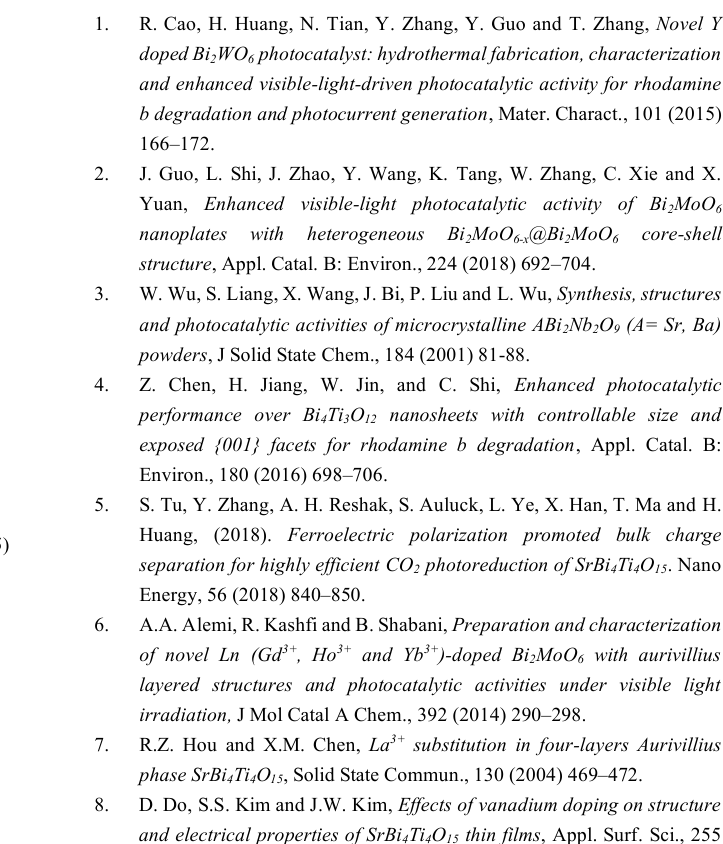
Fig. 4 The reflectance spectra of SrBi 4 Ti 4- n V n O 15 ( n = 0, 0.05, 0.1, and